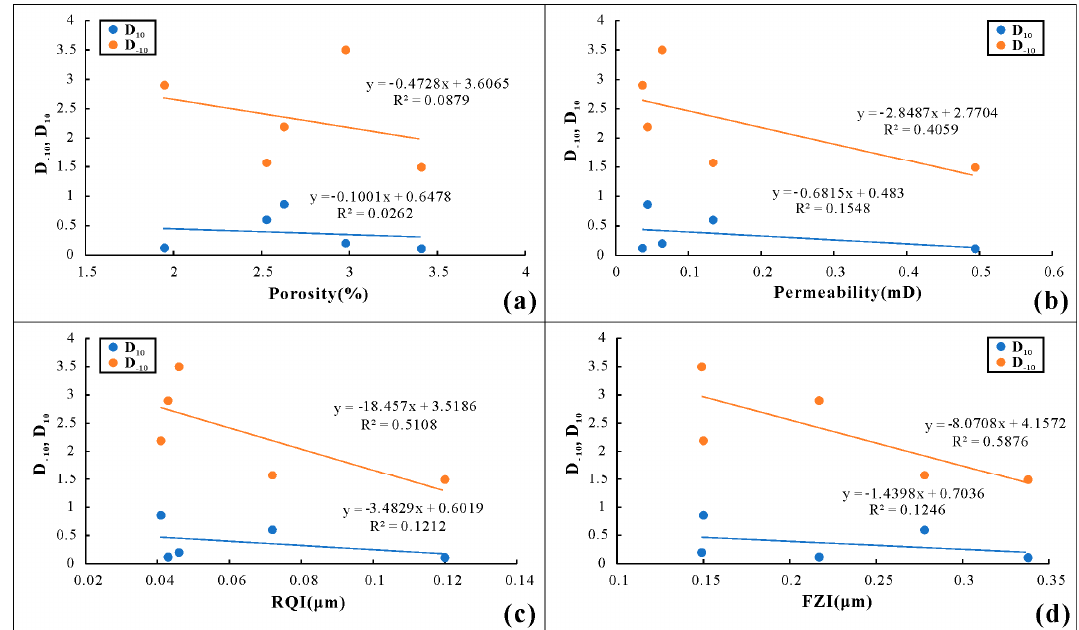
Figure 10. The correlations between petrophysical parameters with multifractal parameters. ( a ) the correlations between D -10 , D 10 with porosity; ( b ) the correlations between D -10 , D 10 with permeability; ( c ) the correlations between D -10 , D 10 with RQI; ( d ) the correlations between D -10 , D 10 with FZI.